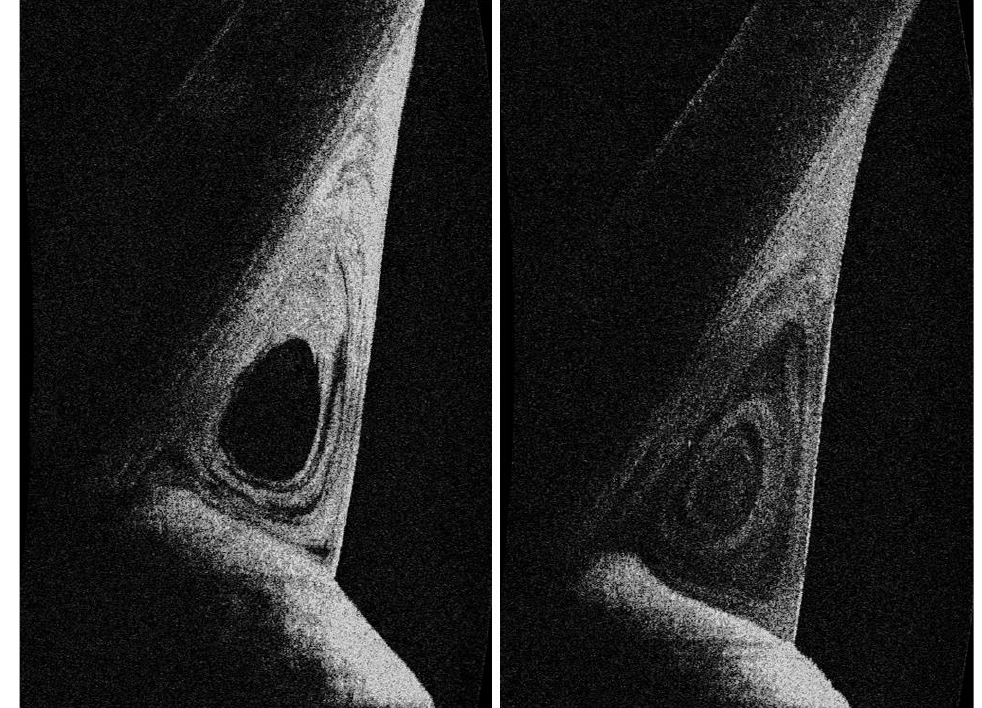
Figure 11. Clearance of human tears in contrast-enhanced optical coherence tomography (OCT) imaging. The flow of lipids in the lower tear meniscus can be reliably observed by OCT imaging after administration of a lipid-based tracer. The latter represents a contrast agent to improve the detection of tear film dynamics. Of note, a vortex pattern in tear distribution may be disclosed in the inter-blink period. OCT imaging was performed in the same conditions of temperature (15 ◦ C–25 ◦ C) and humidity (30%–50%) in a dimly light room [102].